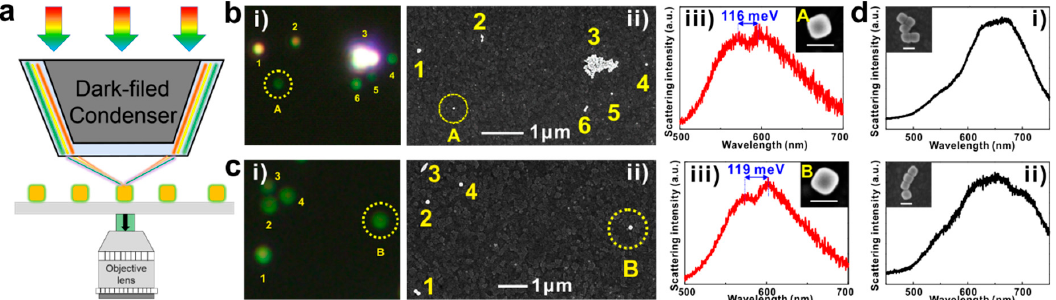
Figure 3. Characterization of a single AuNC@J-agg hybrid. ( a ) The model diagram of dark field microscopy. ( b ) and ( c ) The results of dark field measurements for two individual AuNC@J-agg hybrids. i ) Dark field image. ii ) Corresponding SEM image. iii ) The dark field scattering spectra of points A and B, which correspond to two individual AuNC@J-agg hybrids displaying Rabi splitting of 116 meV and 119 meV. Inset: SEM images of single AuNC@J-agg hybrids. ( d ) The dark field scattering spectra of close-packed AuNC@J-agg hybrids, which cannot exhibit Rabi splitting. Inset: SEM images of assembling AuNC@J-agg hybrids. The scale bars are 100 nm.